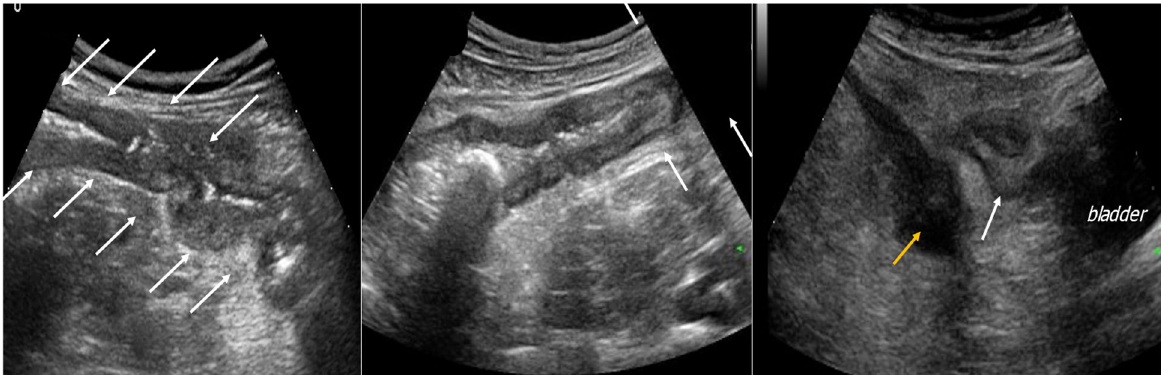
Figure 3. Figures representing Crohn ileitis: the walls are diffusely thickened (white arrows) and a clear distinction between the different parietal layers is lost; the thickening and distortion of the wall can be such as to determine a stenosis of the colon section involved; in the last figure a Crohn ileitis complication is represented [fluid collection (yellow arrow)].